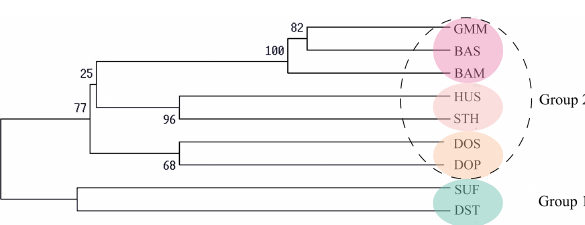
Figure 2. UPGMA phylogenetic tree of nine sheep populations based on Nei’s genetic distance ( D A